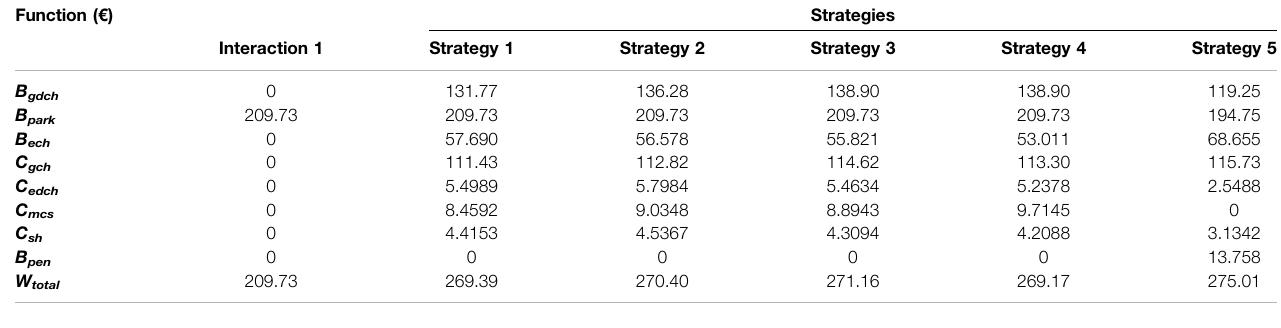
TABLE 5 | Parking pro fi t functions.